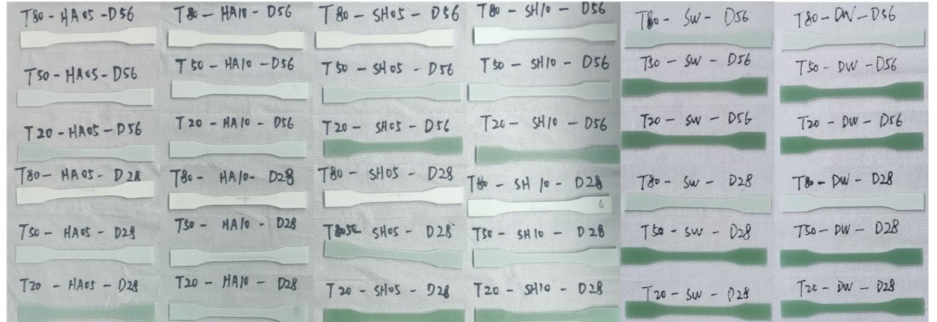
Figure 5. Appearance of specimens after